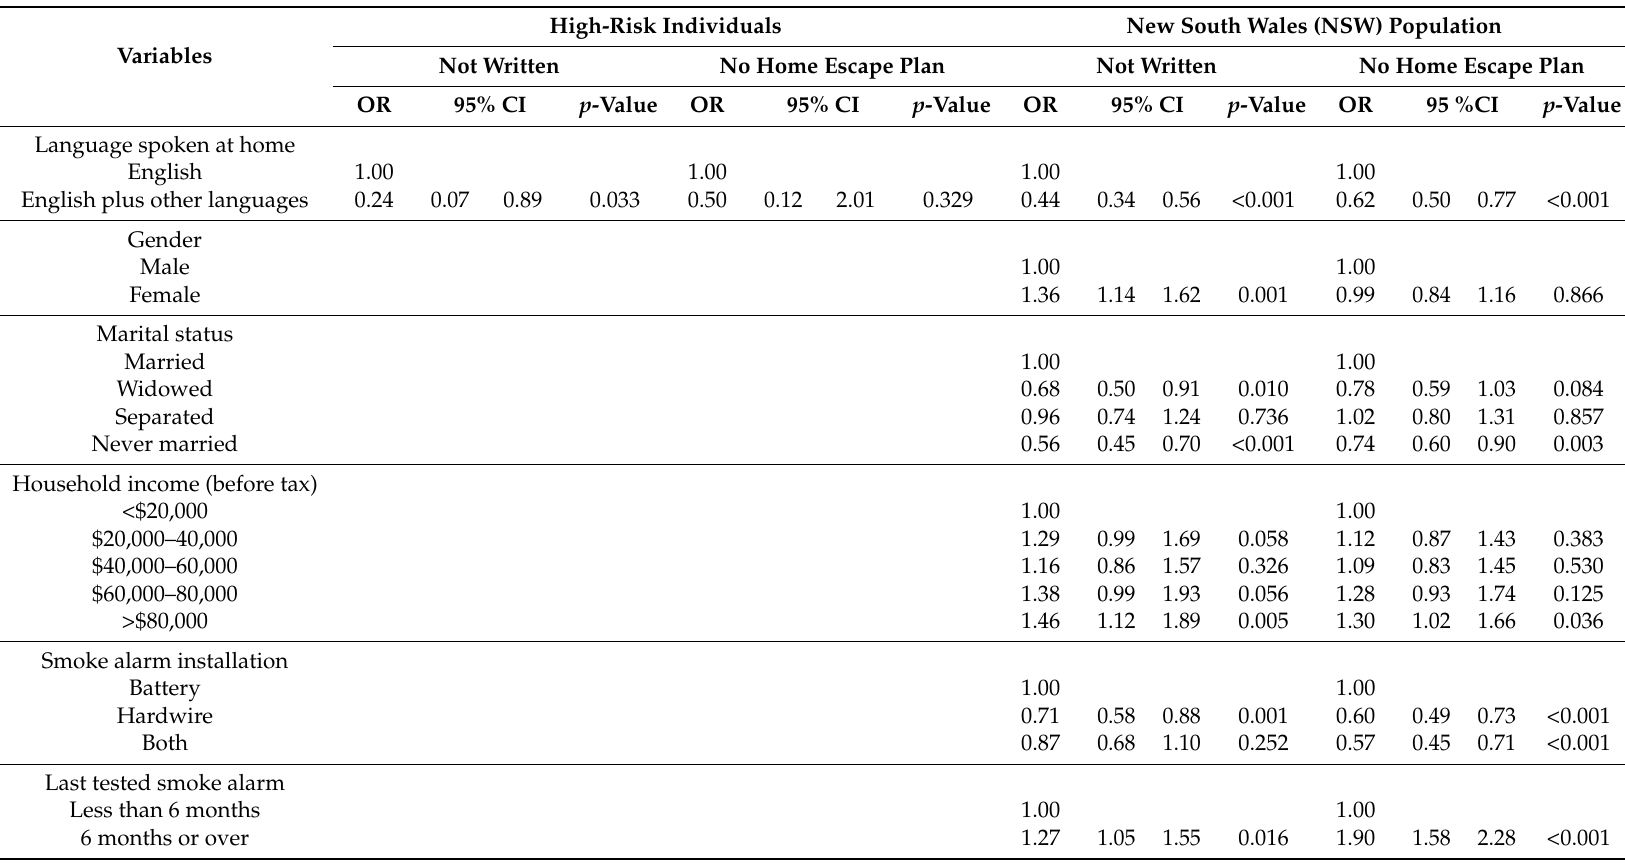
Table 4. Factors associated with home fire escape